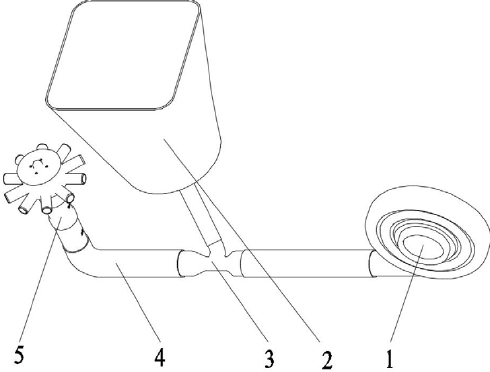
Figure 1. Structure of the pneumatic centralized fertilizer discharge system. (1) fan; (2) fertilizer box; (3) Venturi tube; (4) horizontal pipe; (5) vertical distributor.